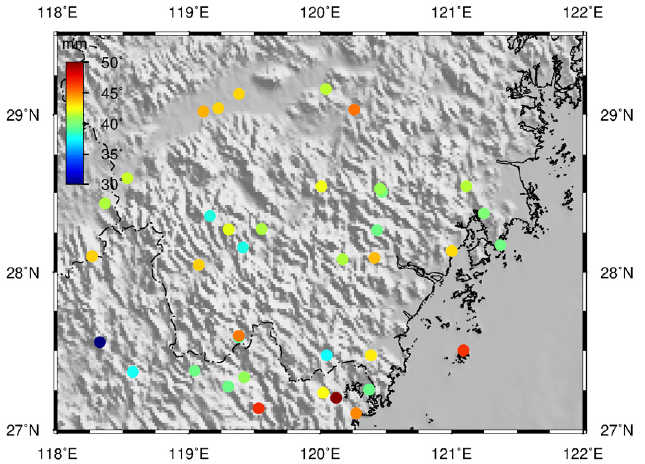
Figure 4. Map with colored dots depicting the amplitude of the reconstructed geodetic height for every site.